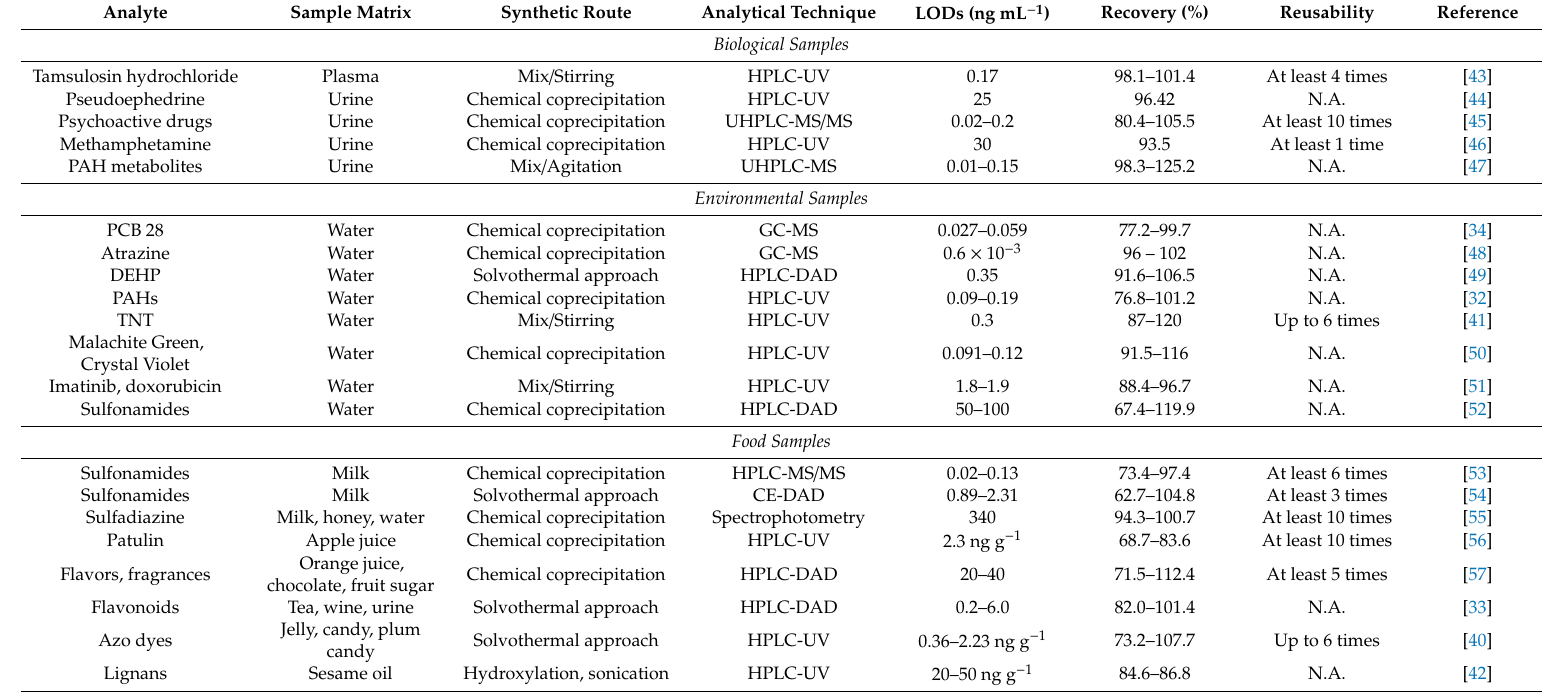
Table 1. Applications of GO / Fe 3 O 4 for the magnetic solid-phase extraction (MSPE) of organic compounds from biological, environmental and food